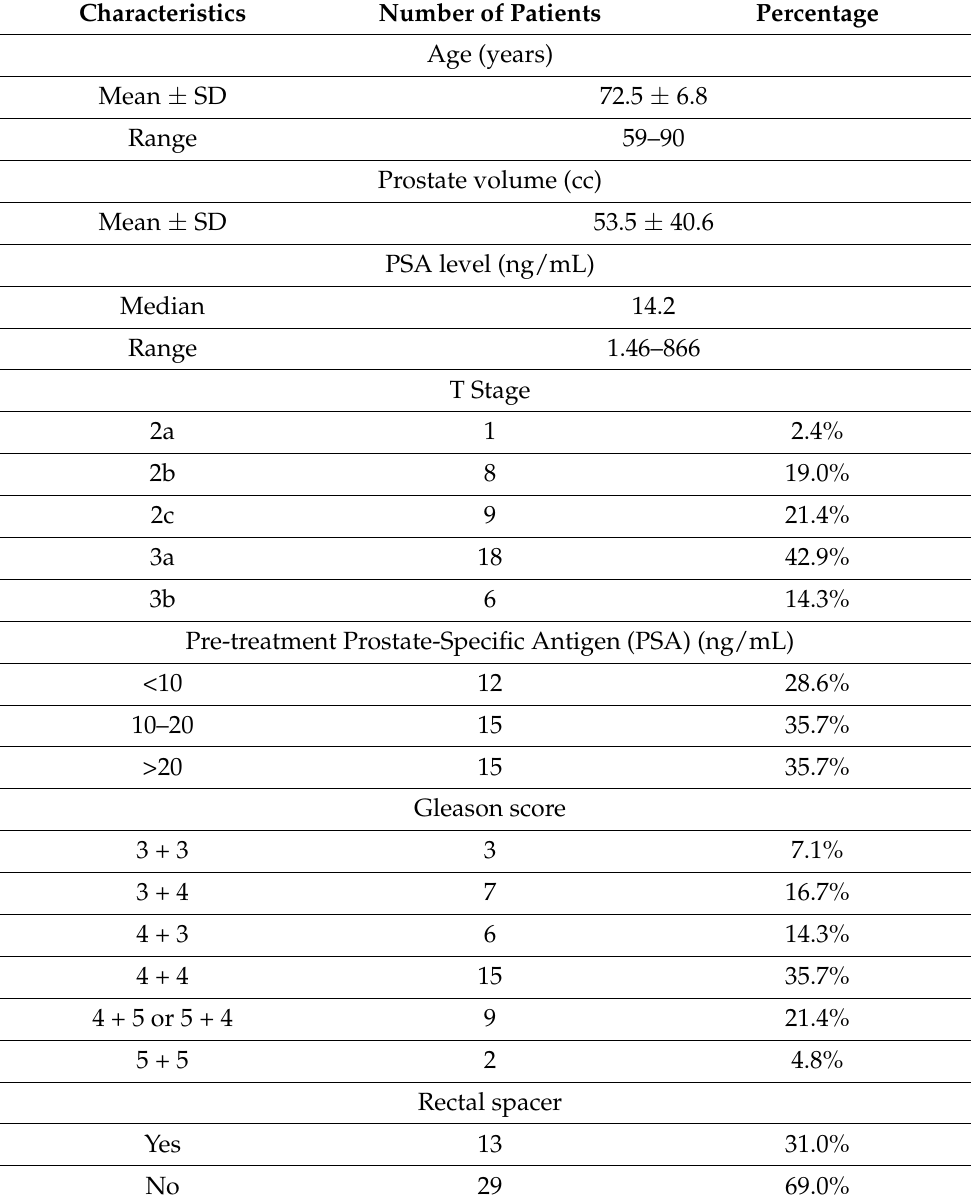
Table 1. High-risk prostate cancer (HR-PC) patient characteristics at baseline ( N =